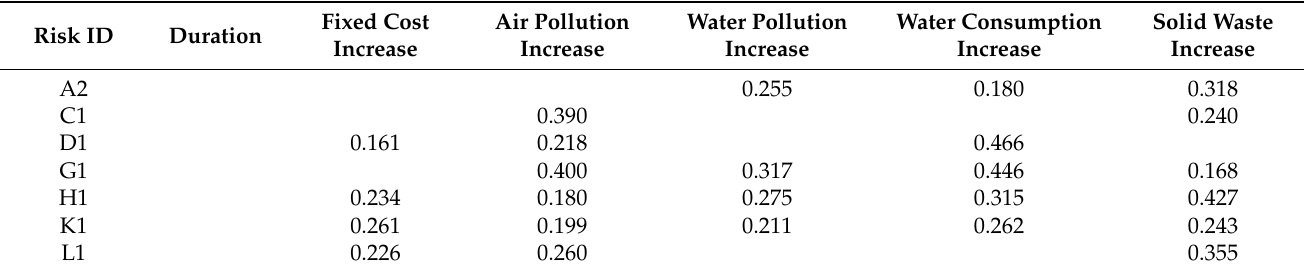
Table 9. Summary results of typical risk factors.